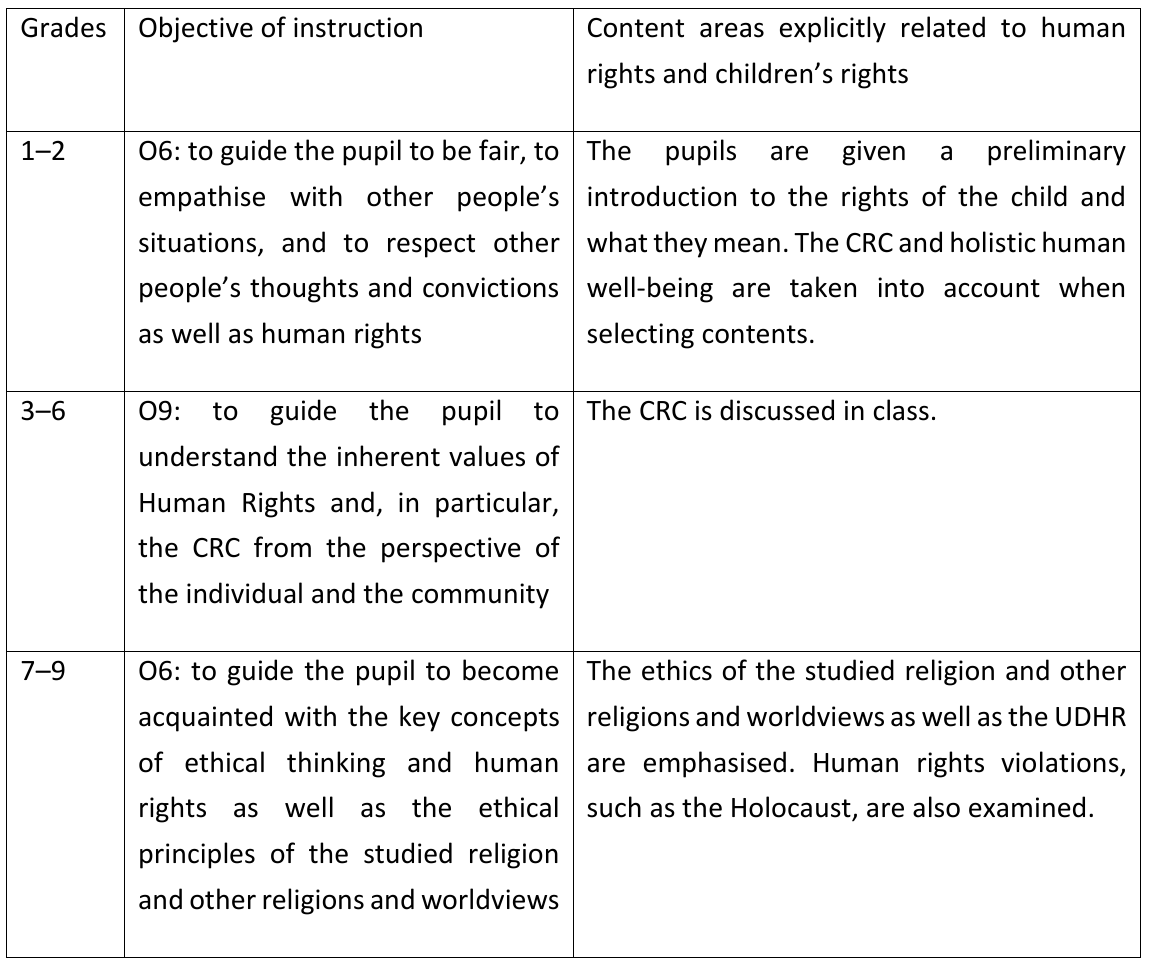
Table 1: Human rights as objectives of instruction and explicit content areas in the